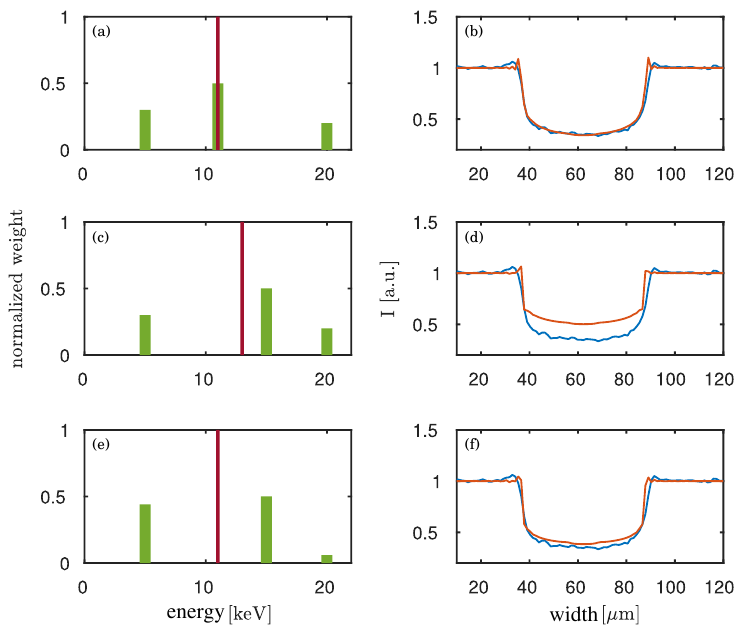
Figure 8. Simulation of the propagation signature of a titanium wire of 50 µ m diameter. On the left ( a , c , e ), three toy spectra with different weighted mean energies (red line) and with different energy distributions are assumed. Three monochromatic lines (green) at 5keV, 11keV and 20keV (( b )) or 5keV, 15keV and 20keV (c/d and e/f), respectively, are used to illustrate the spectra. On the right ( b , d , f ), the corresponding simulated propagation signatures of a 50 µ m titanium wire are shown in orange. Source-blurring is neglected in the simulations. The blue line shows a lineplot of the measurement of the wire. From top to bottom the weighted mean energy of the spectra is 11keV (a/b), 13keV (c/d) and 11keV (e/f). The maximal contributing energy bin of the spectra is 11keV (a/b), 15keV (c/d) and 15keV